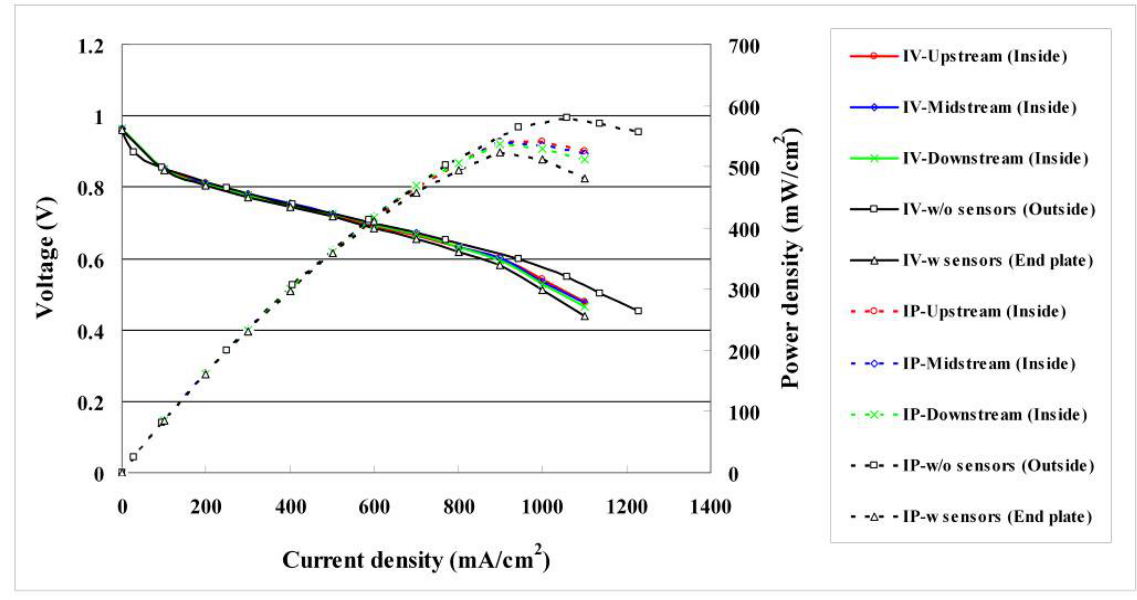
Figure 13. Comparison of polarization curves.